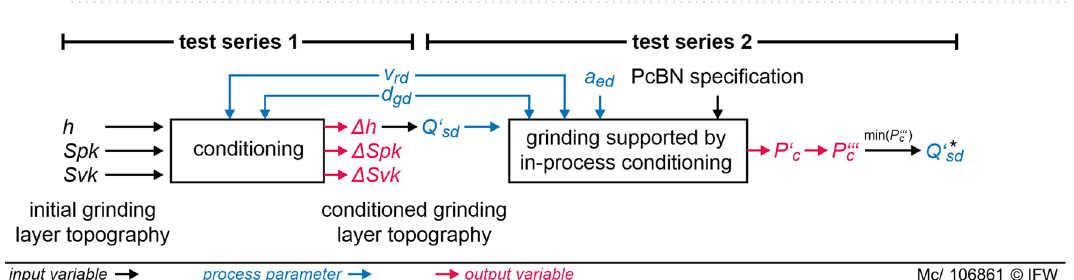
Figure 1. Kinematics of in-process conditioning during face plunge grinding. The cup conditioning tool is mounted parallel to the surface of the cup grinding wheel.